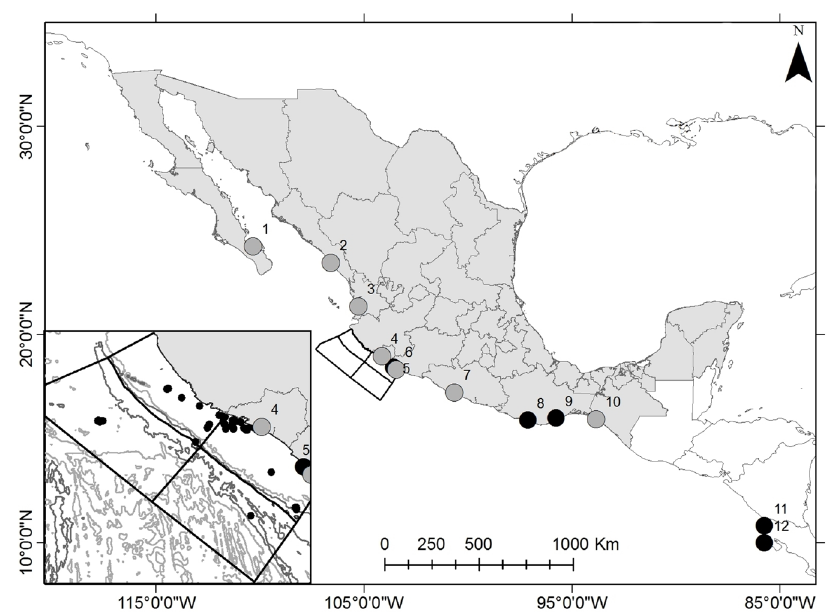
Figure 1. Location of olive ridleys caught in the Central Mexican Pacific between November 2011 and July 2012. The study area was divided into 4 strata: northern continental, southern continental, northern oceanic, and southern oceanic. Gray and black circles indicate locations of solitary and arribada nesting beaches, respectively. Major olive ridley nesting beaches in the Eastern Tropical Pacific outside our study area are included. 1: Punta Colorada, BCS; 2: El Verde Camacho, Sinaloa; 3: Platanitos, Nayarit; 4: Cuyutlán, Colima; 5: Ixtapilla, Michoacán; 6: Colola, Michoacán; 7: Piedra de Tlacoyunque, Guerrero; 8: La Escobilla, Oaxaca; 9: Morro Ayutla, Oaxaca; 10: Puerto Arista, Chiapas; 11: Nancite, Costa Rica; 12: Ostional, Costa Rica.